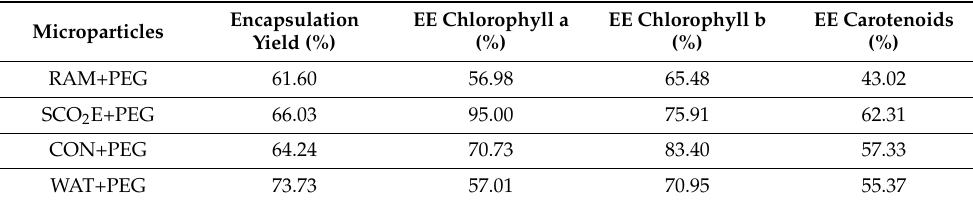
Table 1. Encapsulation yield and pigment encapsulation efficiency for microparticles obtained with the PGSS process.